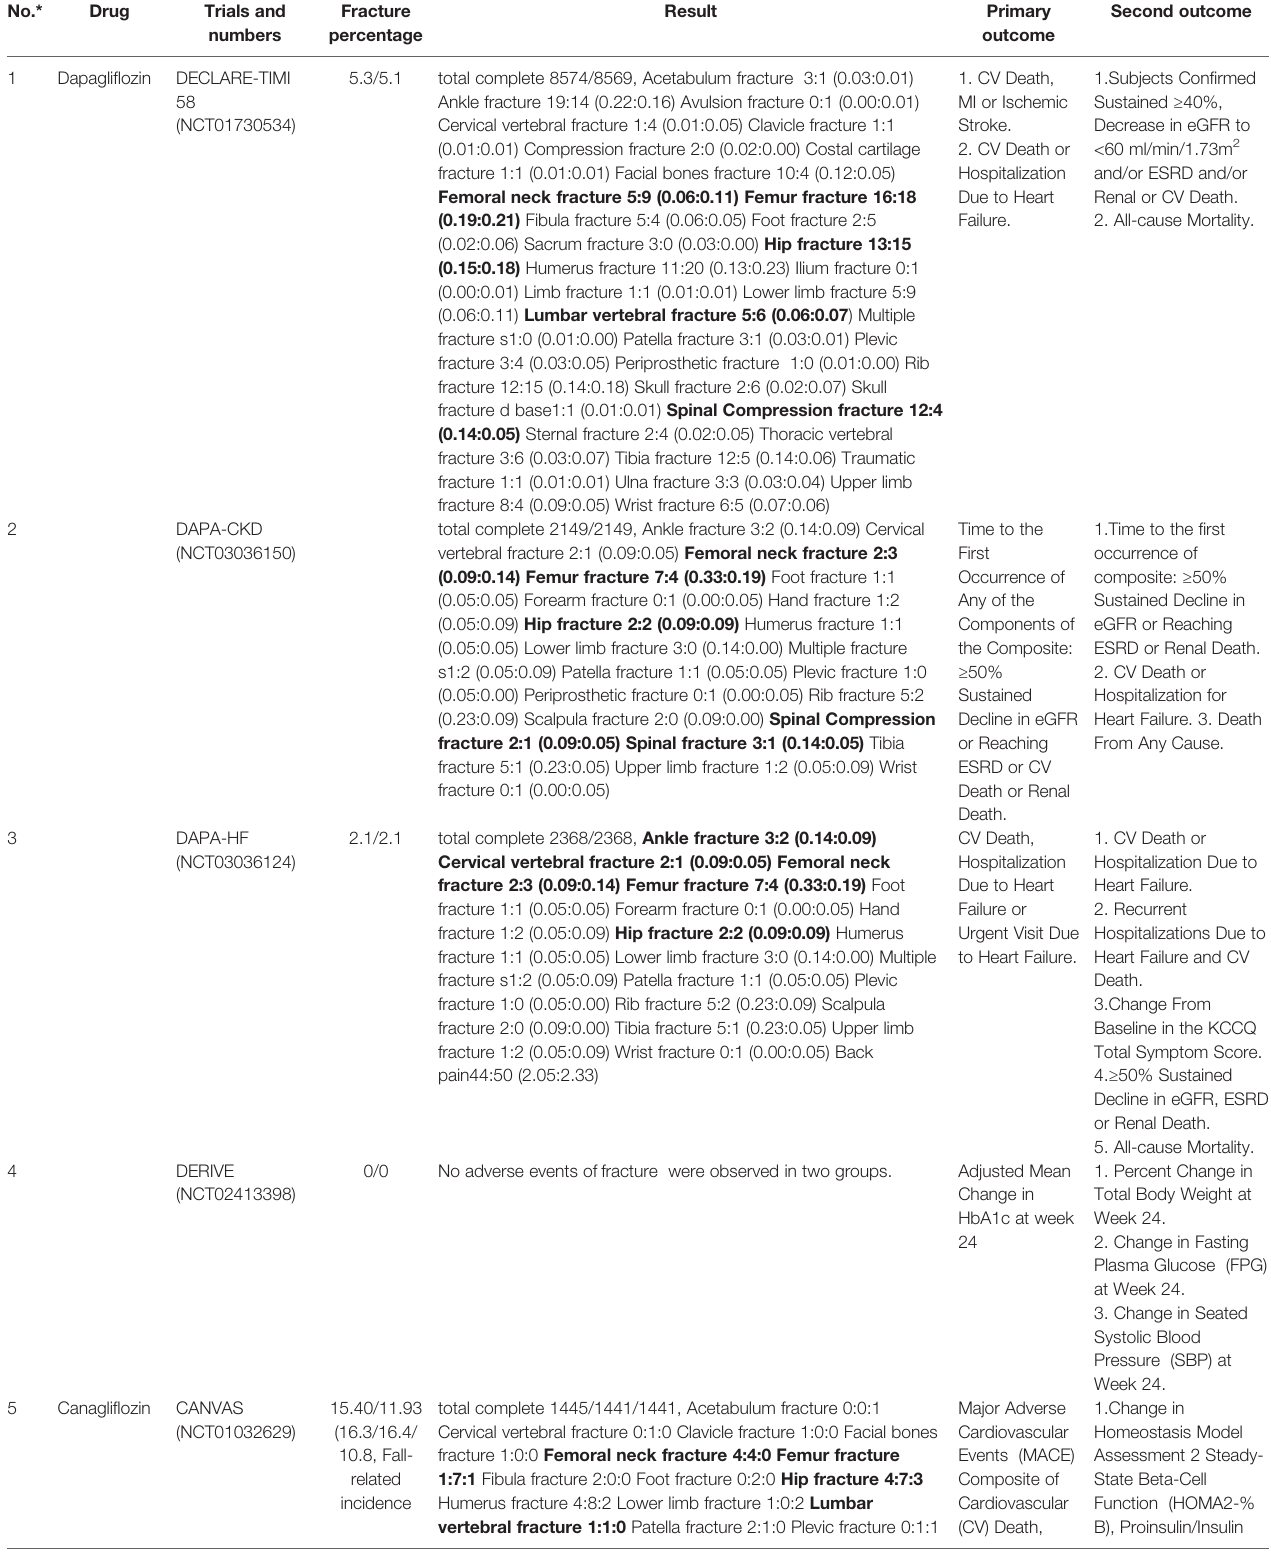
TABLE 3 | Clinical trials information about SGLT2is and bone fracture risk.